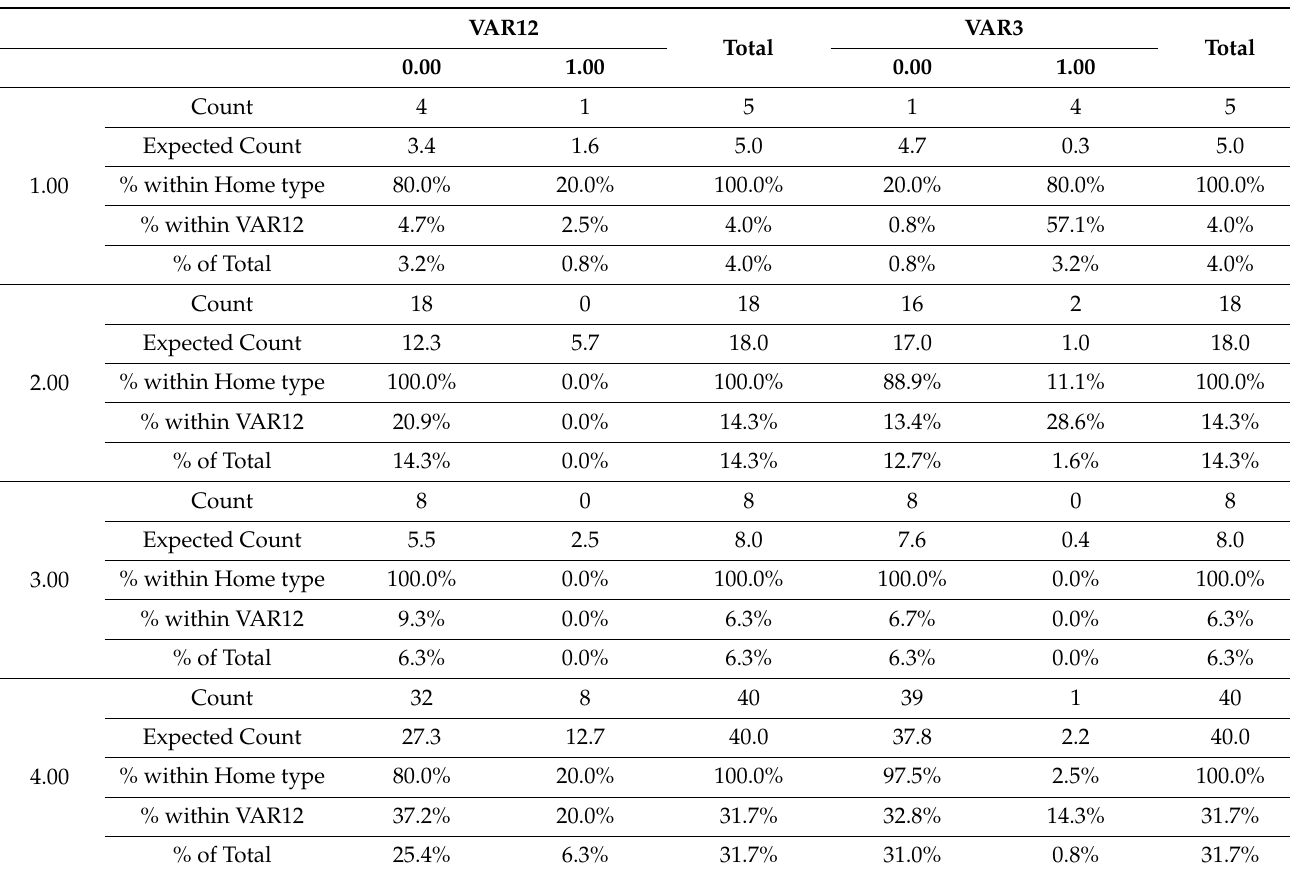
Table A2. The difference between individuals with different ideal property type in which they would like to live against variables 3 and